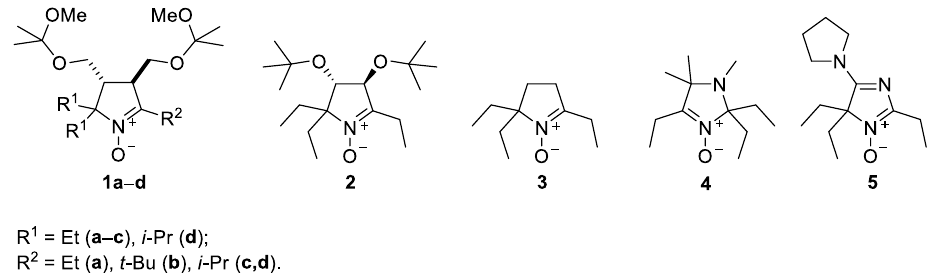
Figure 1. The sterically hindered nitrones used in this study.